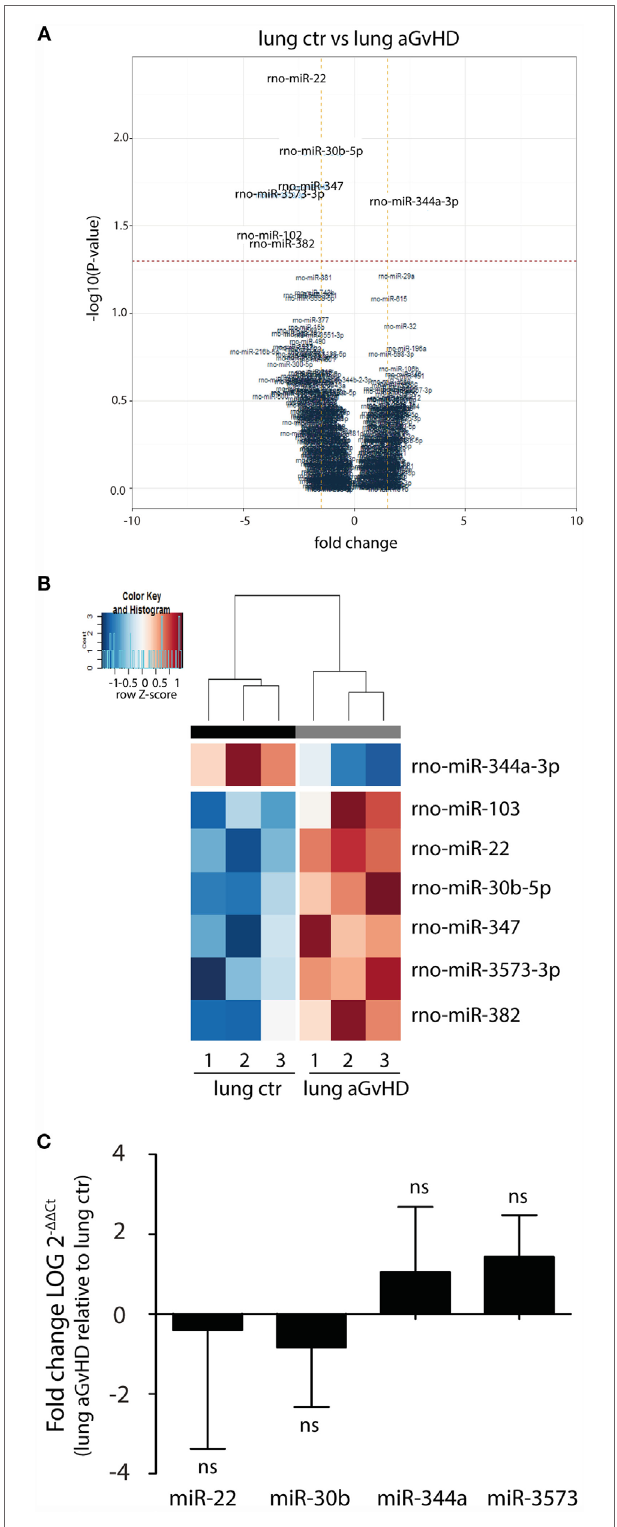
FigUre 3 | mirna expression signature in lung during agvhD .